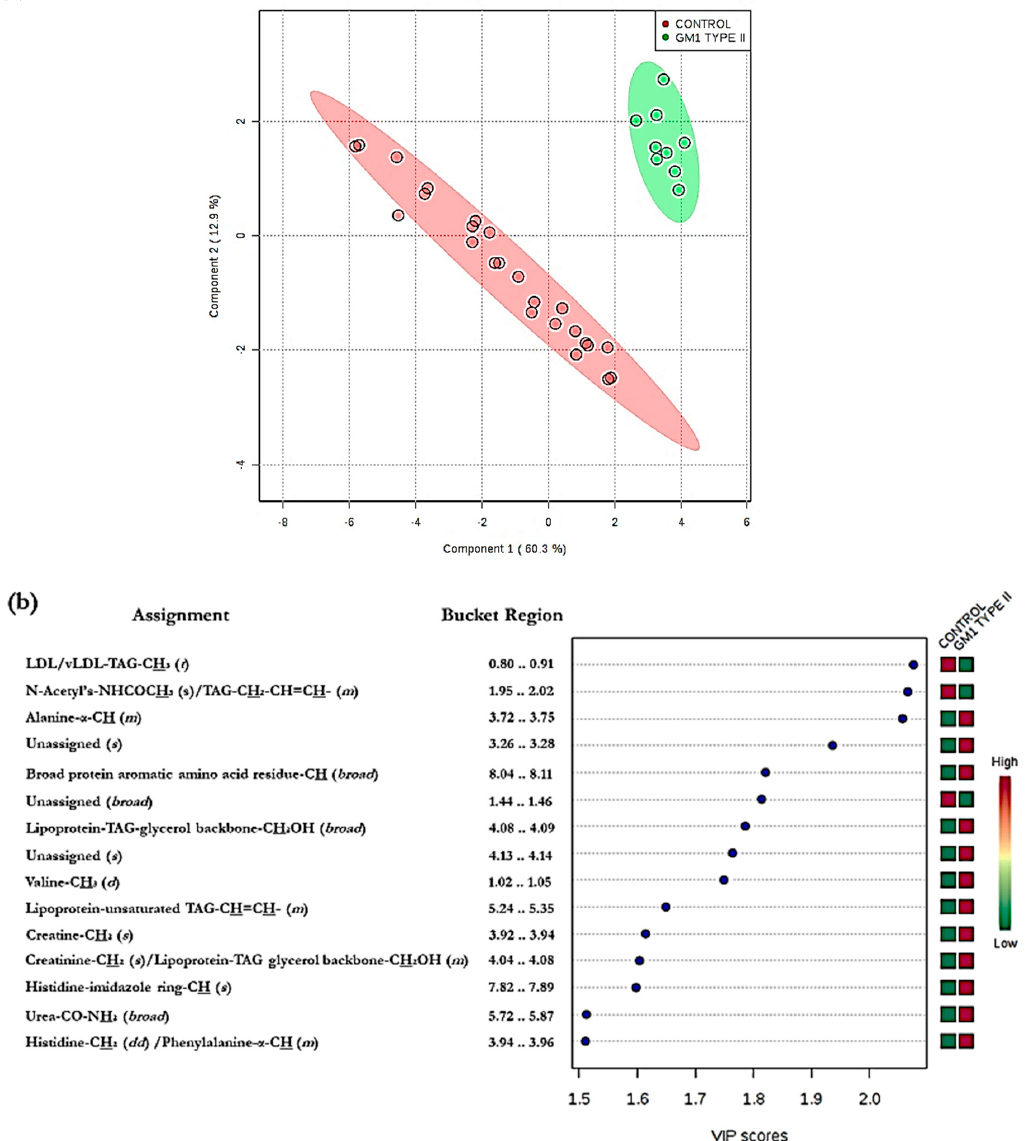
Figure 3. Multivariate analysis of spectral data from GM1 Type II and control plasma integral bucket regions. ( a ) PLS-DA scores plot showing controls (red) and GM1 Type II (green) together with 95% confidence ellipses. PC1 and PC2 represent 60 and 13% of the dataset variance respectively. Removal of all glucose ISB regions, which were clearly elevated in GM1 Type II participants in view of the non-fasting of participants, was performed prior to simulation of this plot. ( b ) Plot of variable importance parameter (VIP) values arising from the PLS-DA analysis, showing significantly greater intensity intelligent bucket regions, with their corresponding metabolite assignments. The red and green right-hand side abscissa axis represent metabolites which are elevated or depleted in GM1 Type II or control plasma samples respectively. The higher the VIP score, the more important the bucket region is considered in the PLS-DA model (all VIP values ≥ 1 are considered significant). Abbreviations: LDL, low-density-lipoprotein; TAG, triacylglycerol; vLDL, very-low-density-lipoprotein. A unique strategy included observing all the lipidoses simultaneously using an LC-MS-MS investigation into plasma hexosylsphingosine, globotriaosylsphingosine, lysosphingomyelin and lysosphingomyelin-509 levels [82]. This investigation observed patients with FD ( n = 16), GD ( n = 8),